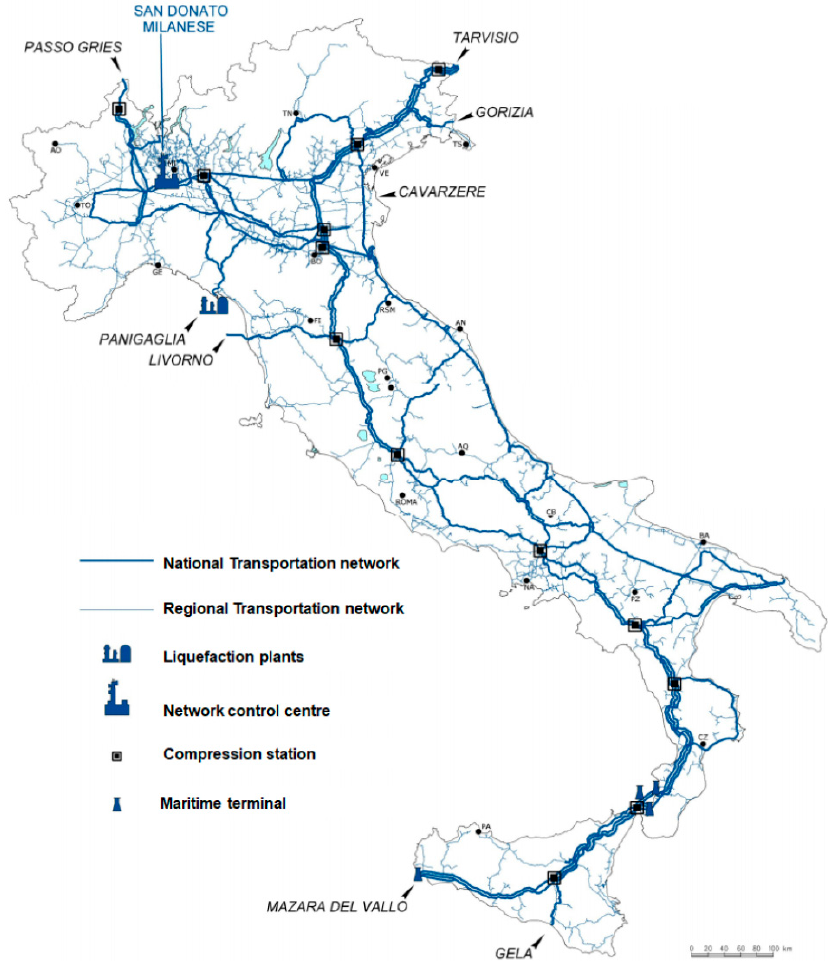
Figure 1. The Italian National and Regional Transmission Systems [26].